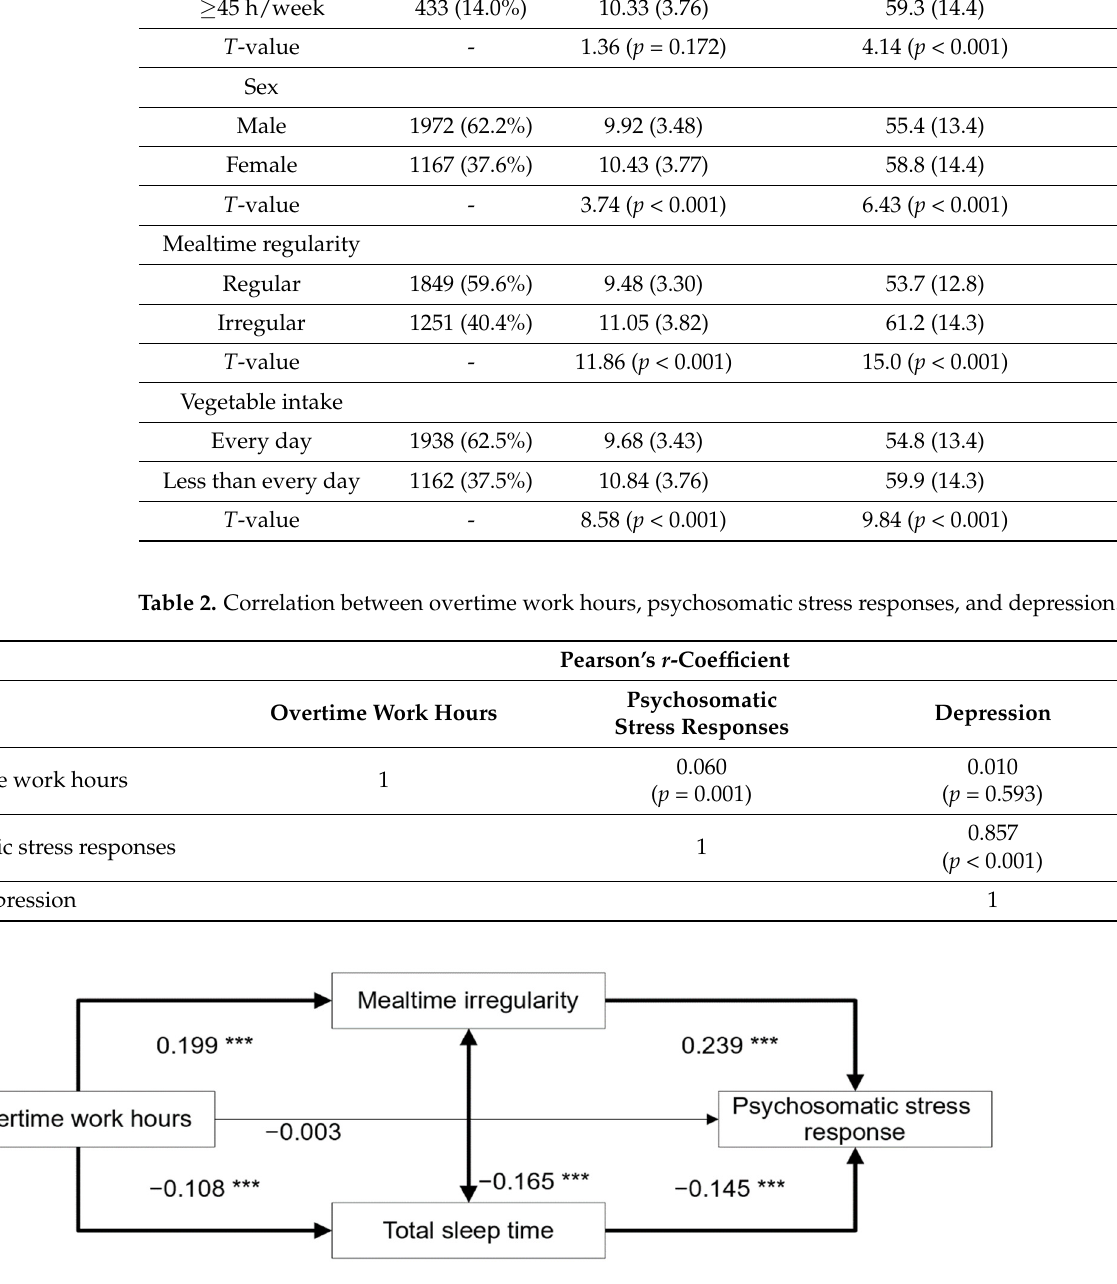
Figure 1. Structural equation model of the effect of overtime work hours on psychosomatic stress responses. The bold arrows represent statistically significant direct paths. The numbers adjacent to the arrows indicate the standardized path coefficients. *** p < 0.001.